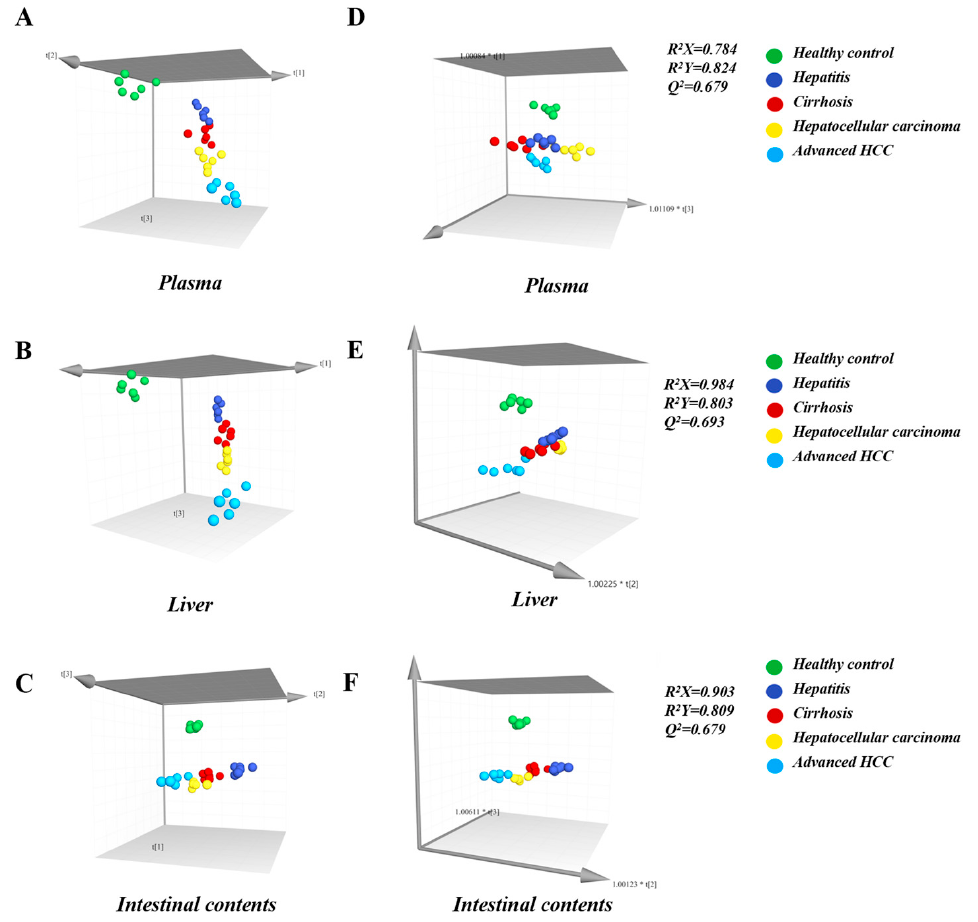
Figure 5. ( A – C ): PCA score plots and ( D – F ): OPLS-DA score plots of plasma, liver, and intestinal contents samples. In the PCA score plot, the distance between points indicates the difference between samples. The fact that the disease groups are clustered together and separated from the healthy groups indicates that the different groups in the experiment can be well distinguished from each other. R 2 X and R 2 Y in the OPLS-DA score plot indicate the explanation rate of the proposed model for the X and Y matrices, respectively, and Q 2 marks the predictive power of the model. Usually, the values of R 2 X, R 2 Y, and Q 2 are higher than 0.5 can indicate that the model fits with acceptable